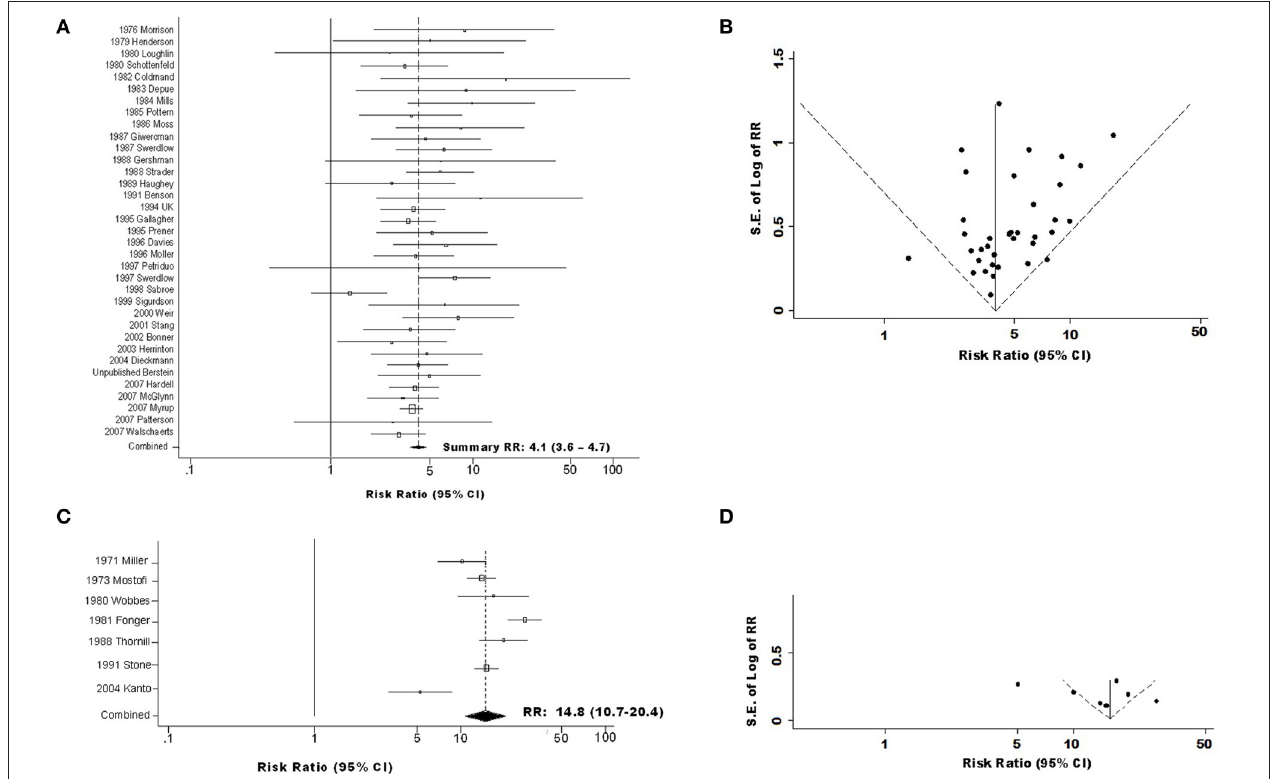
FIGURE 1 | Forest and funnel plots for overall association of testicular germ cell tumor (TGCT) risk with history of cryptorchidism (A) Forest plot for combined cohort and case-control